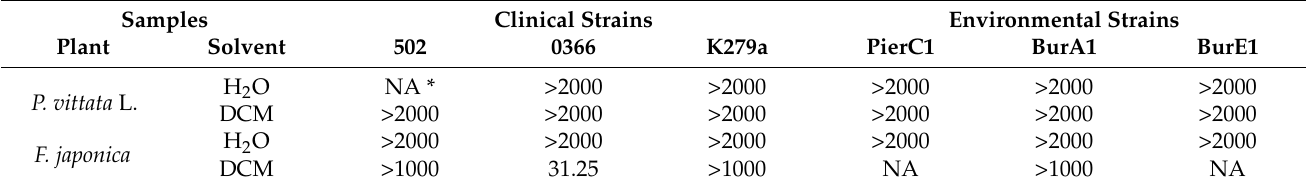
Table 2. Antibacterial activities (Minimum inhibitory concentration (MIC) expressed in µ g/mL) of P. vittata L. and F. japonica aqueous and DCM fractions on six S. maltophilia strains.